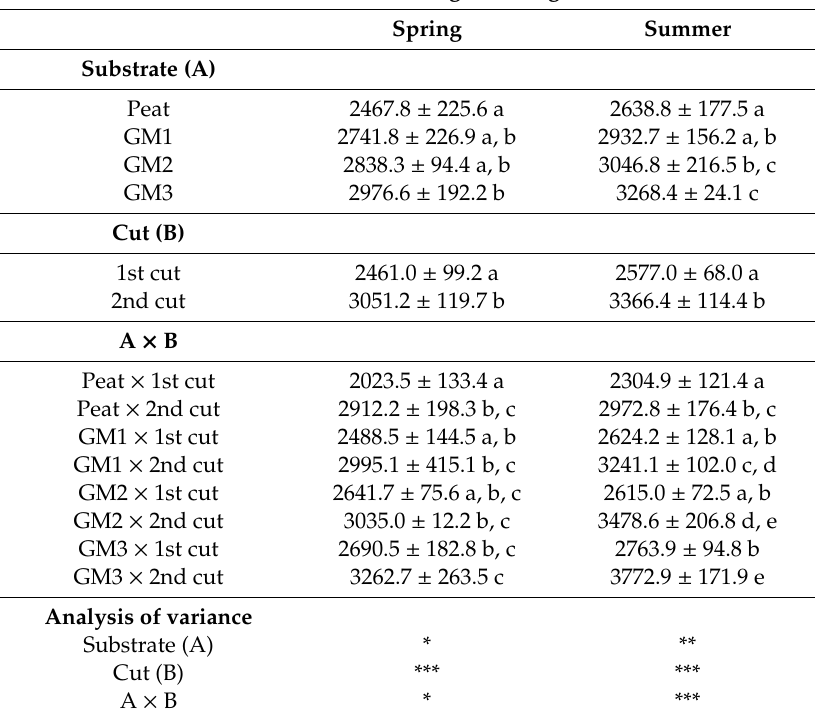
Table 5. Total phenolic content in the leaves of baby leaf red lettuce grown on di ff erent growing media (peat, GM1, GM2, GM3) and harvested twice (1st and 2nd cut), cultivated in spring and summer cycles in a floating